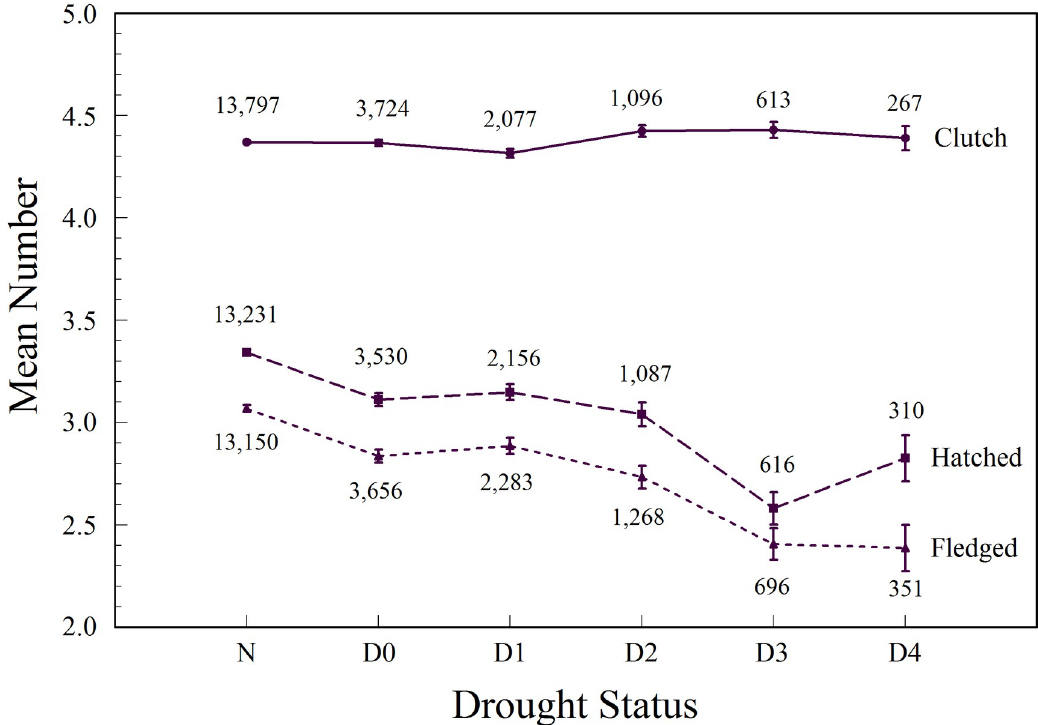
Fig 4. Mean number of Eastern Bluebird eggs laid (clutch size), eggs hatched, and young fledged by North American Drought Monitor drought status categories, 2006–2013.